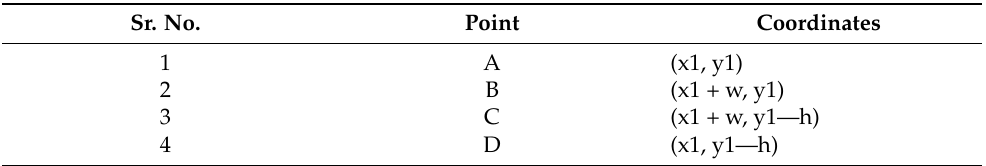
Table 2. Cartesian coordinates for the 2D bounding box with top left corner A (x,y), height h, and width w.